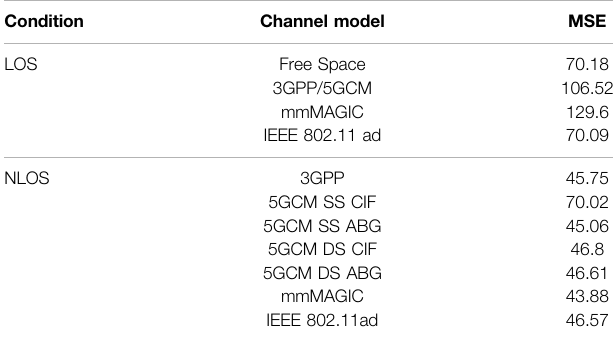
TABLE 5 | MSE values obtained from each channel model for the of fi ce cubicle